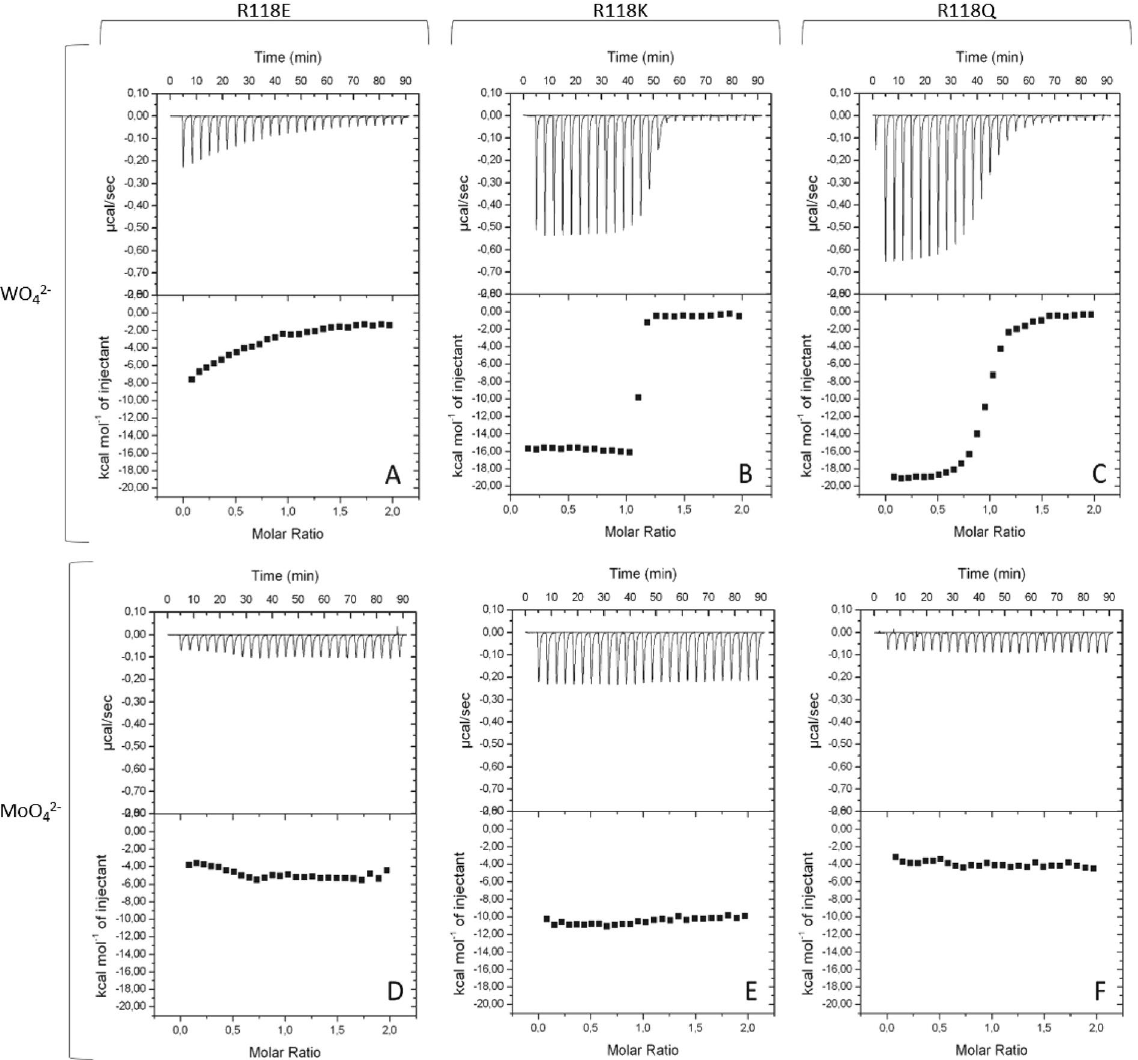
Figure 8. Isothermal titration calorimetry of ligand binding to TupA variants. 10 µ M of the variant R118E ( A,D ), R118K ( B,E ) or R118Q ( C,F ) was titrated with injections of 100 µ M of WO 4 ( A,B,C ) and 100 µ M of MoO 4 ( D,E,F ). Data were fitted with ORIGIN software. The raw ITC data are shown in the top graphs.